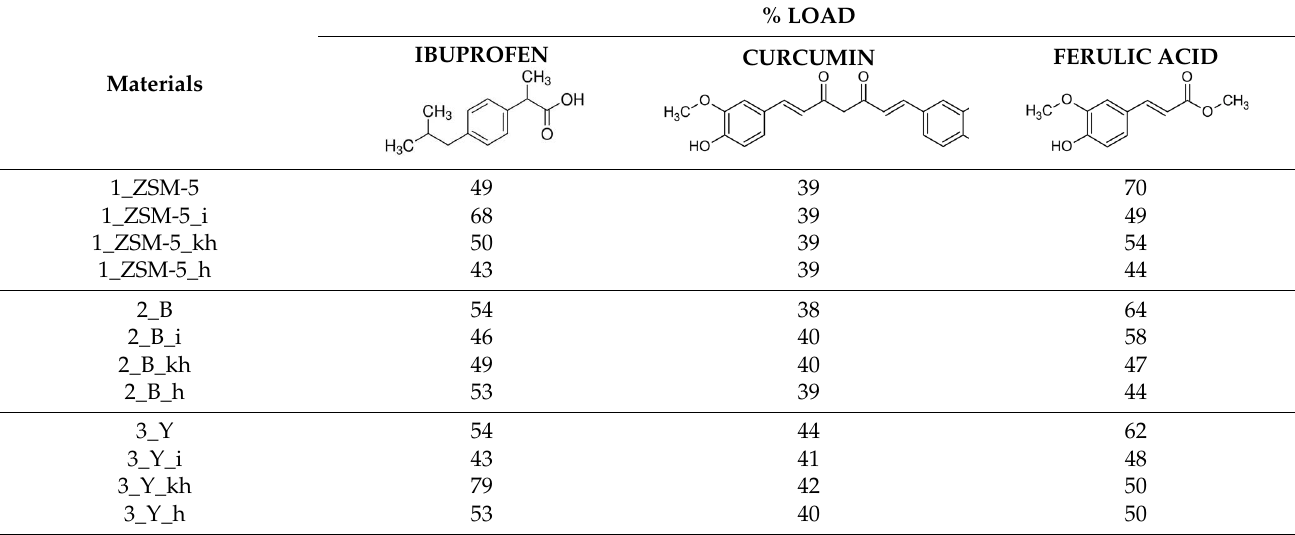
Table 4. Active substances loading into hierarchical zeolites.